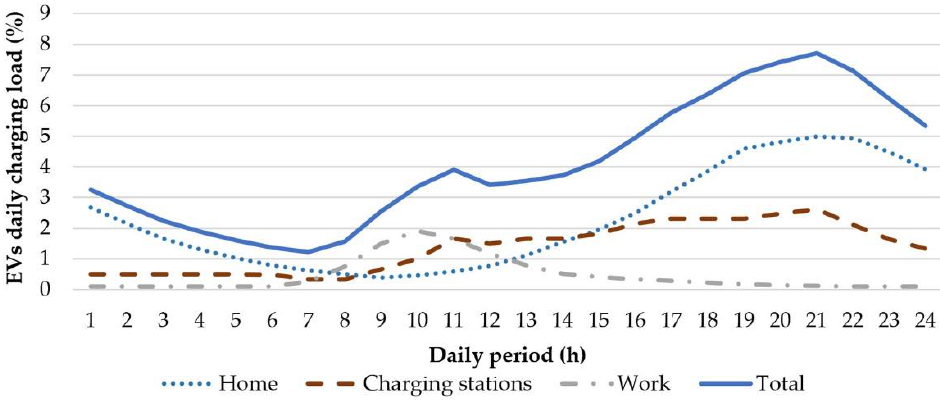
Figure 5. Daily charging load profiles for the EVs.